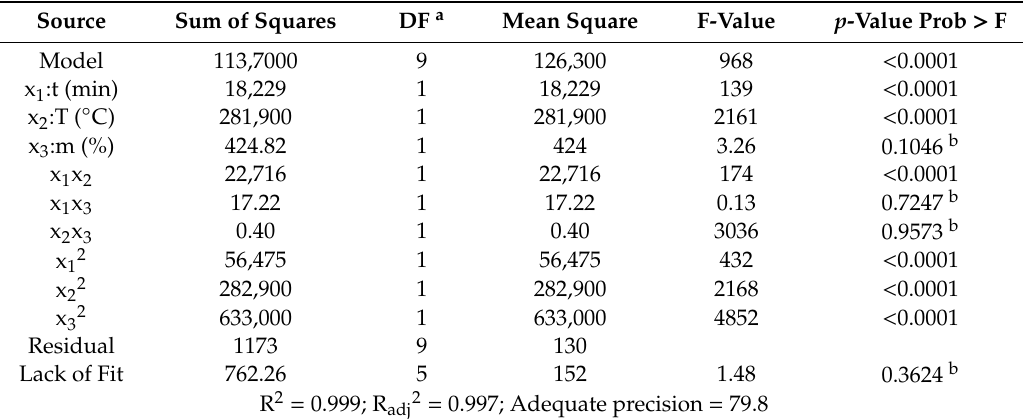
Table 3. Analysis of variance of the model regression for adhesion strength